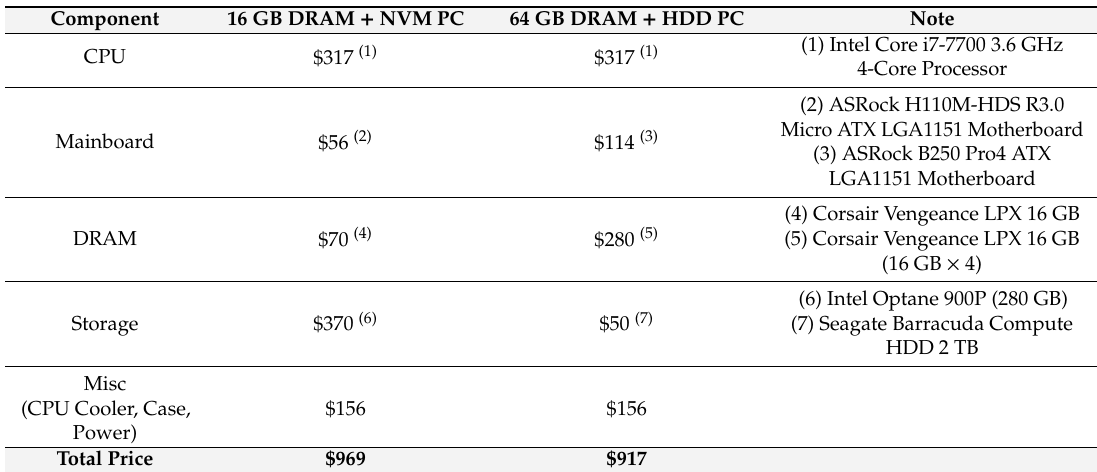
Table 2. Specifications of a “large DRAM and slow HDD PC” and a “small DRAM and fast NVM PC”.